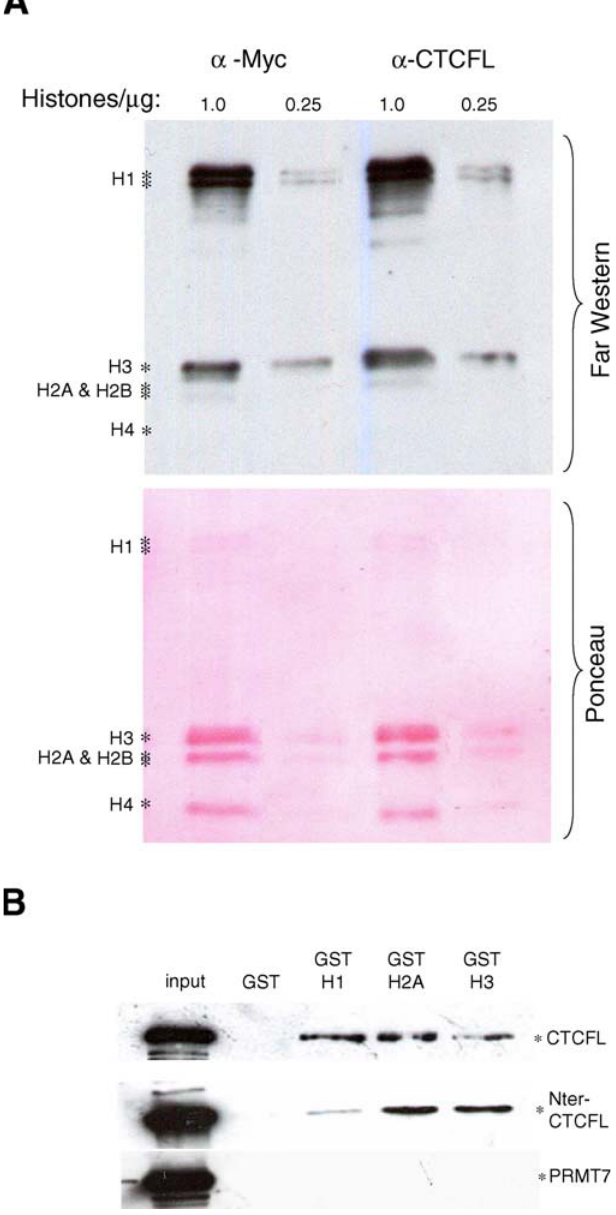
Figure 4. CTCFL Interacts with Histones H1, H2A, and H3 (A) Farwestern analysis. Western blots containing 1- l g and 0.25- l g histones were reacted with transfected 293T cell lysates expressing myc- tagged CTCFL. The presence of CTCFL was detected by a -Myc and a - CTCFL antibodies. Individual histones are indicated. The lower panel shows the ponceau red–stained Western blot. The migration of the individual histones are indicated to the left. (B) N-terminal and full-length CTCFL interacts with histones H1, H2A, and H3. Bacterial-produced GST histone fusion proteins were reacted with lysates from 293T cells transfected with either full-length or N-terminal CTCFL expression vectors. No detectable interaction of PRMT7 with histones is observed. DOI: